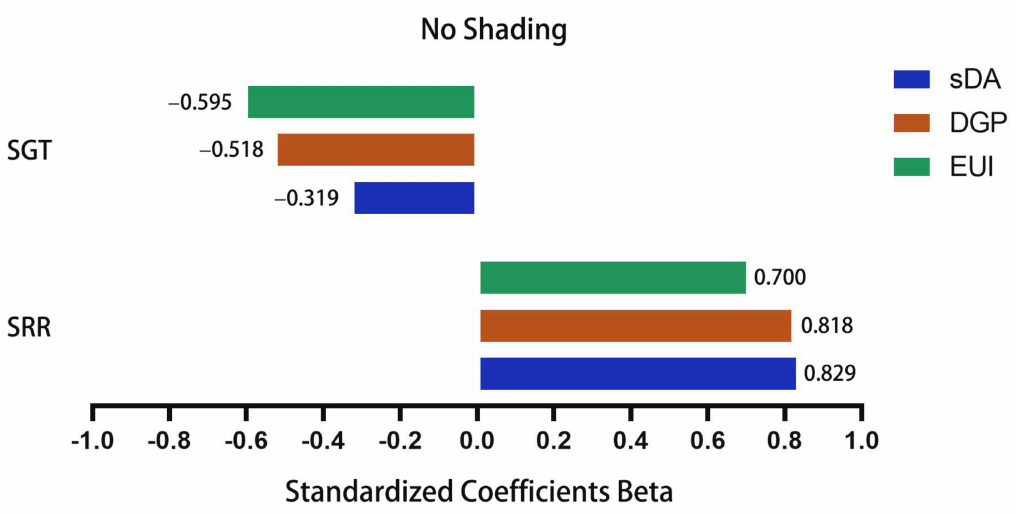
Figure 18. Sensitivity analysis of no shading commercial atrium SAS design